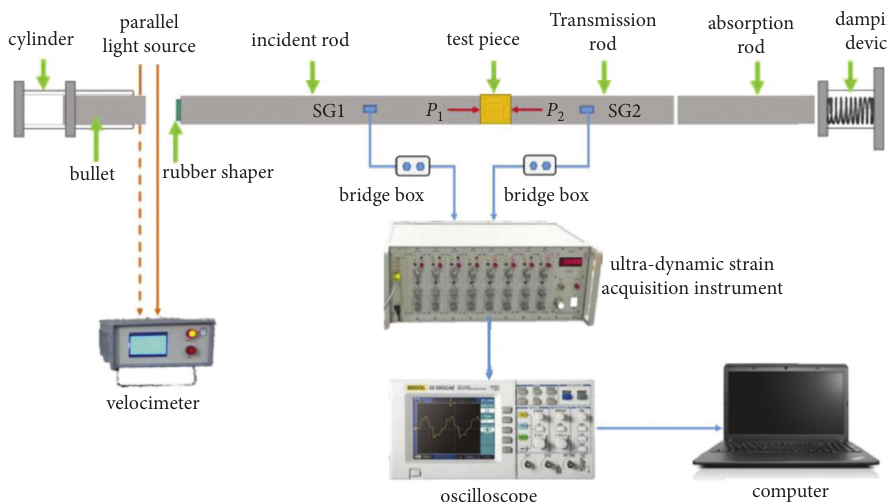
Figure 4: Schematic diagram of the Hopkinson pressure bar test